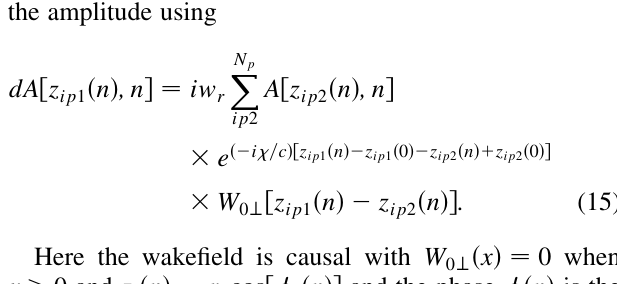
(cid:5) 0 (cid:5) 12 cm 1 : 5 and 1 ? (cid:5) 3 nsecs . (cid:1)